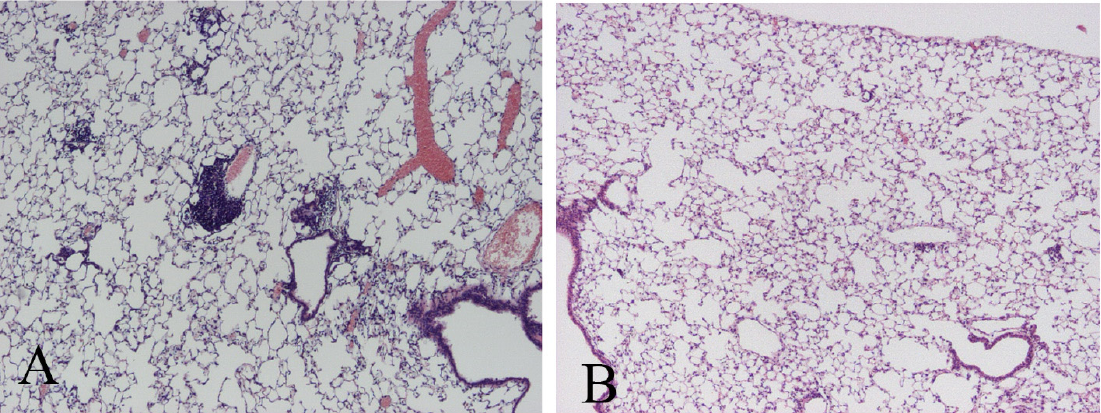
Figure 5. Histology of lungs from mice 60 days after M. avium administration. ( A ) Wild mice (BALB/c) administered M. avium, ( B ) NF-kB deficient mice administered M. avium . Note the marked inflammatory cell infiltrate in the lungs from wild mice compared with NF- κ B deficient mice. Original magnification × 40. Three experiments were done and demonstrated similar results.